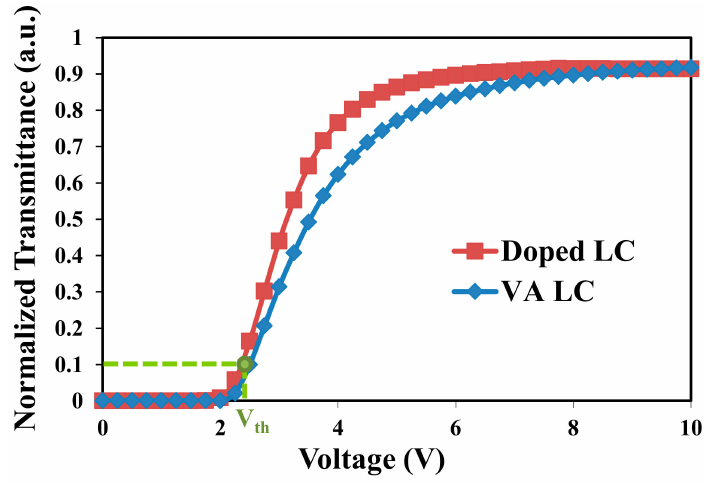
Figure 4. Electro-optical curves of 0.1 wt %-gelator-doped negative LC LCT-06441 (red squares) and VA host LC (blue diamonds)